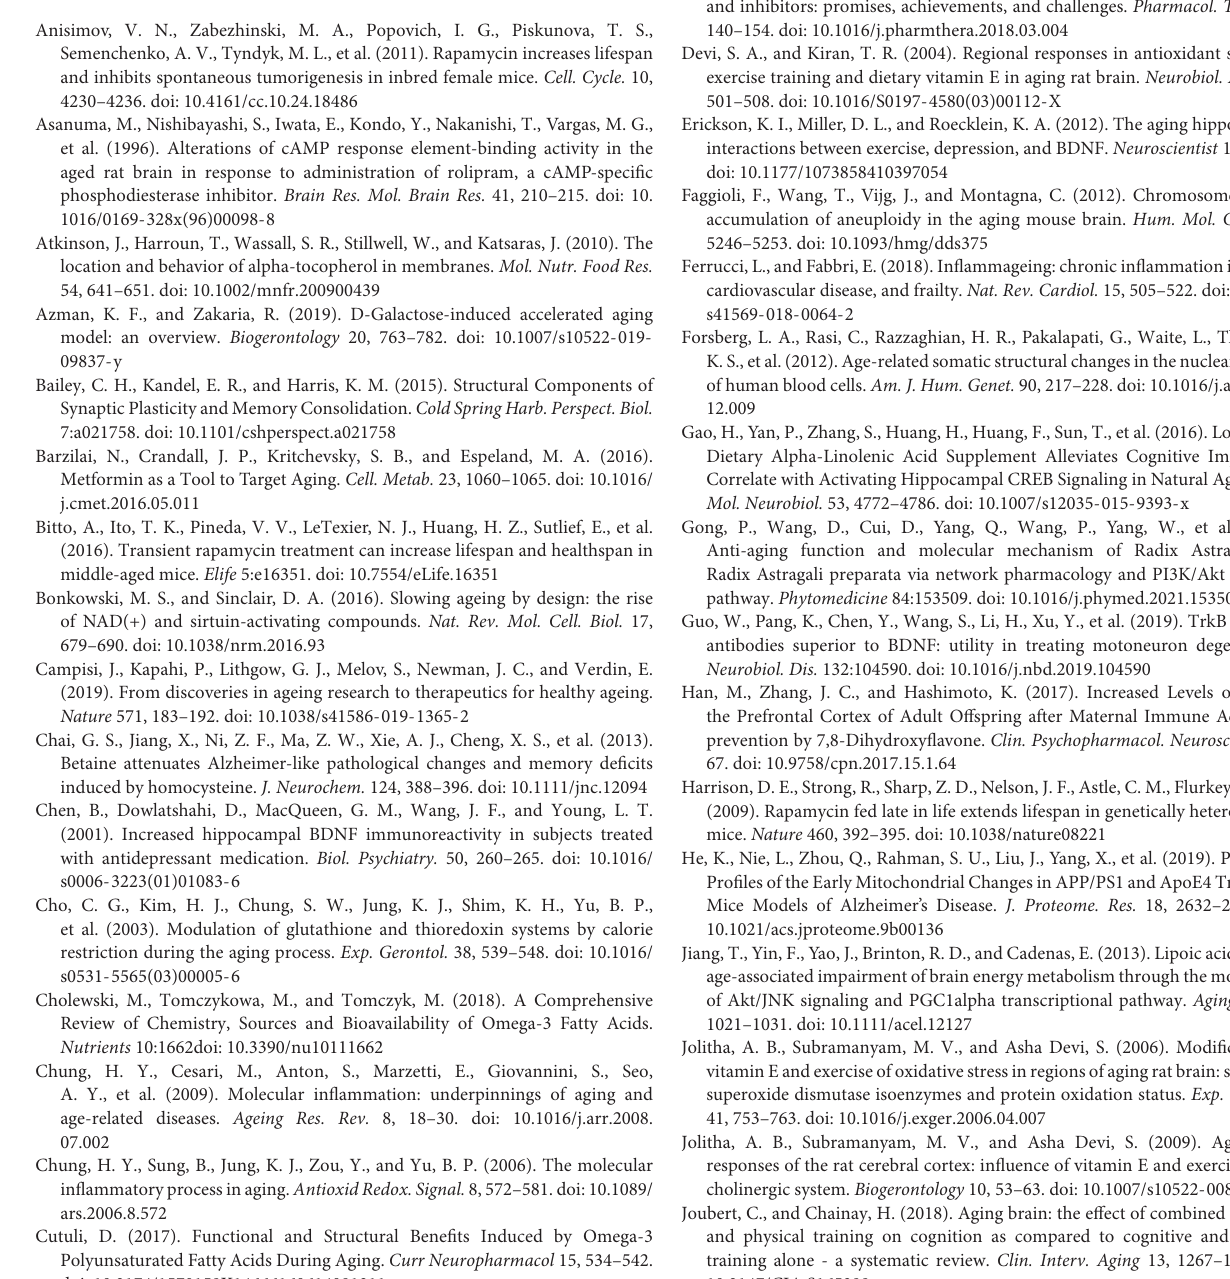
Supplementary Figure 2 | MCODE analysis for the DE proteins of the aging control mice vs. the young control mice. Detected PPI modules for aging related proteins. Supplementary Figure 3 | Volcano plot for the identified proteins of the oil-treated aging mice and biological process for forty-four proteins reversed by seed oil treatment in the aging mice. (A) Volcano plot for the identified proteins of the oil-treated aging mice and (B) enrichment analysis by biological process.